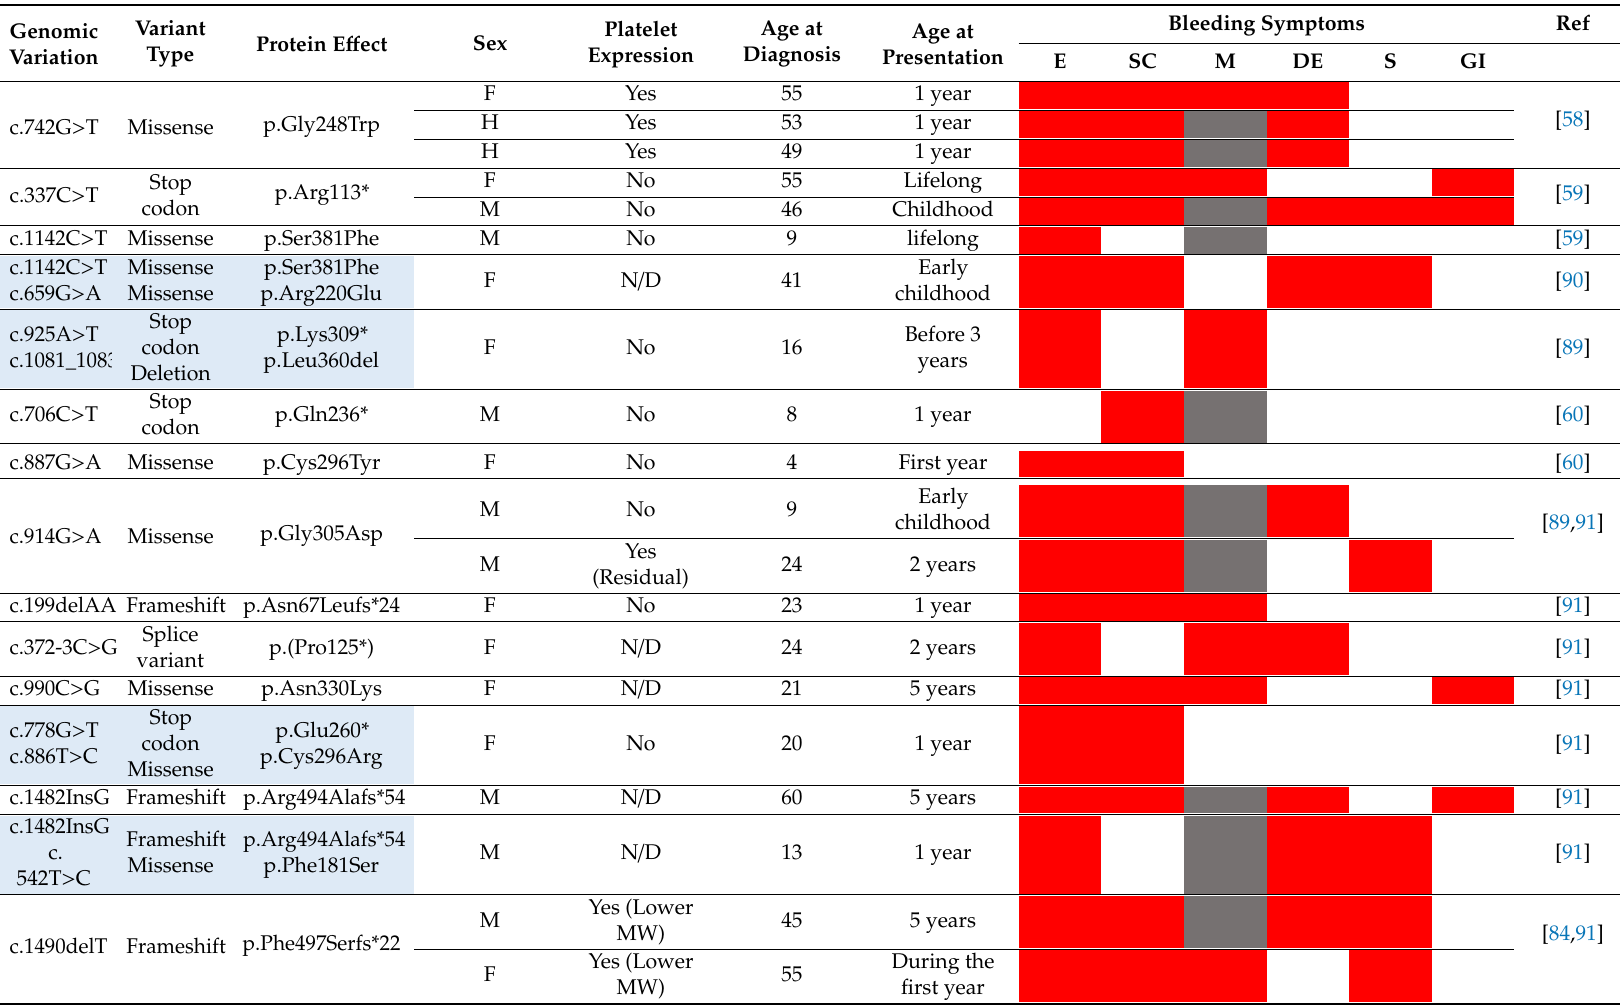
Table 1. Characteristics and bleeding symptoms of the pathogenic RASGRP2 variants reported to